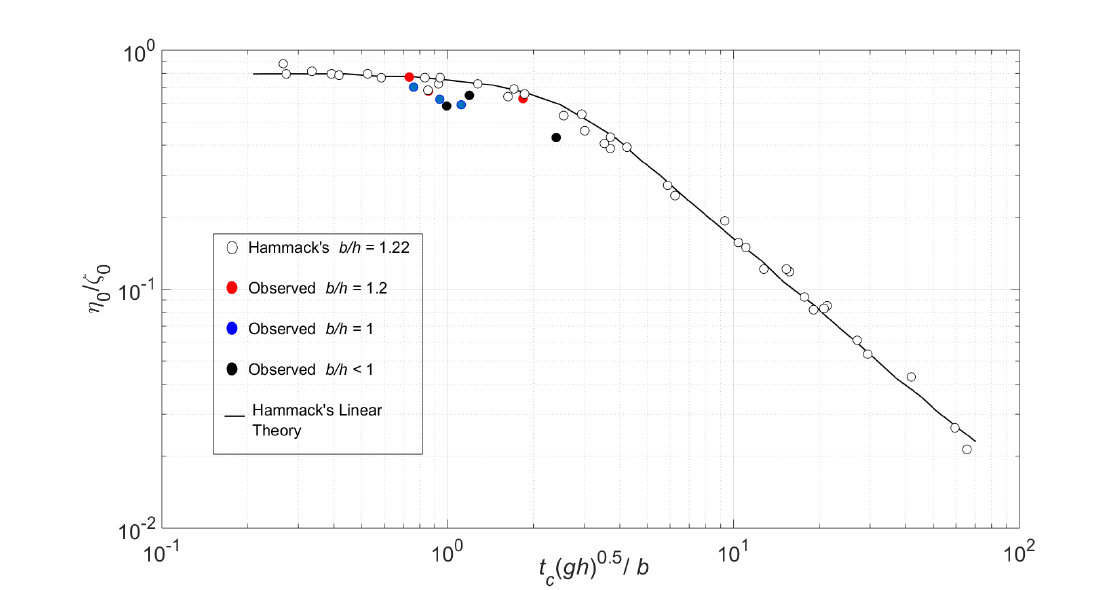
(cid:112) gh / b at WG2